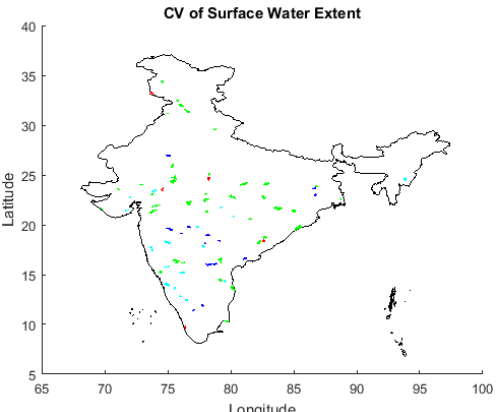
Figure 7, the spatial variability of the CV of wetlands is shown.